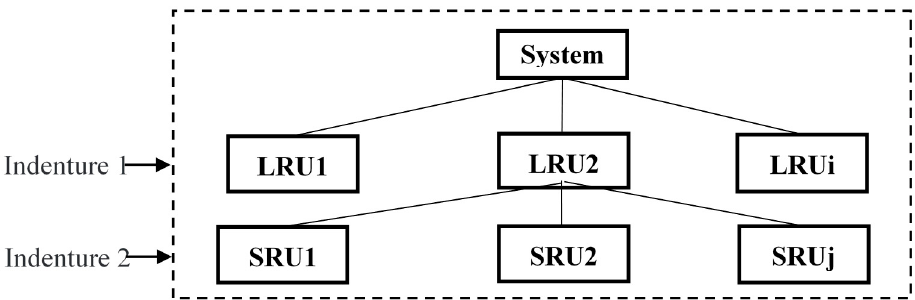
Figure 1. Two-indenture system structure.